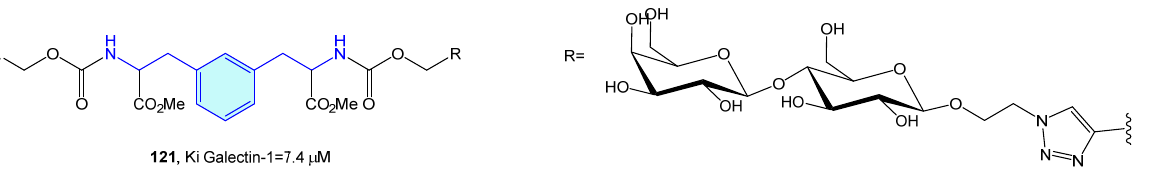
Figure 14. 2-Phenylethyl-based galectin-1 receptor ligands.